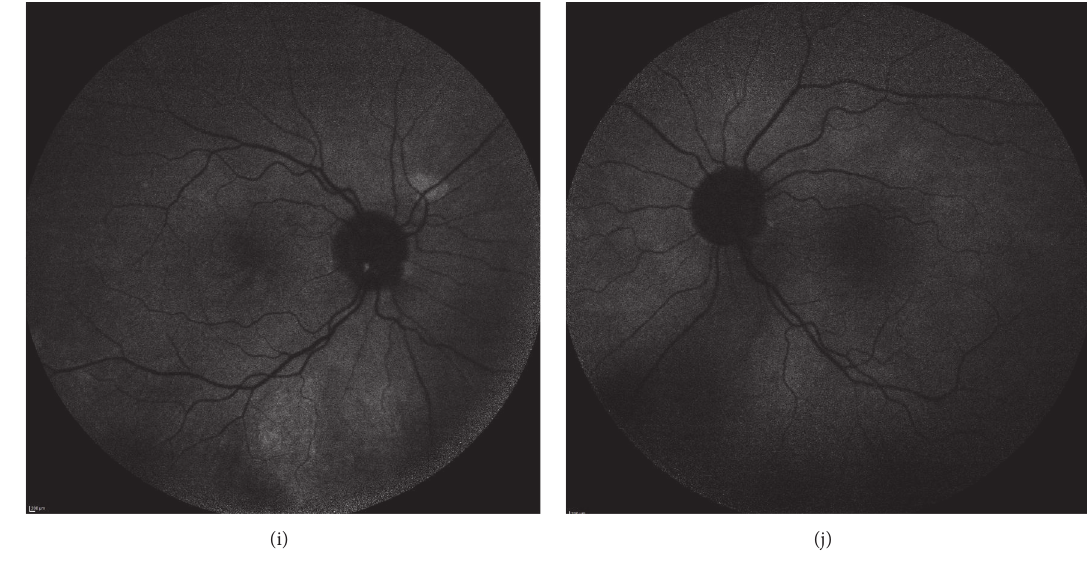
Figure 1: Patient 1. (a), (c), (e), and (g): right eye. (b), (d), (f), and (h): left eye. (a) and (b): fundus examination showing small pigment epithelium alterations in the foveal area without obvious vascular abnormalities. (c), (d), (e), and (f): fluorescein angiography (min and min) showing perifoveal telangiectasia with late intraretinal staining. (g) and (h): spectral-domain optical coherence tomography (B-scan) showing cystoid macular edema with a central macular thickness measured to 312 𝜇 m on the right eye and to 345 𝜇 m on the left eye. (i) and (j): autofluorescence images were